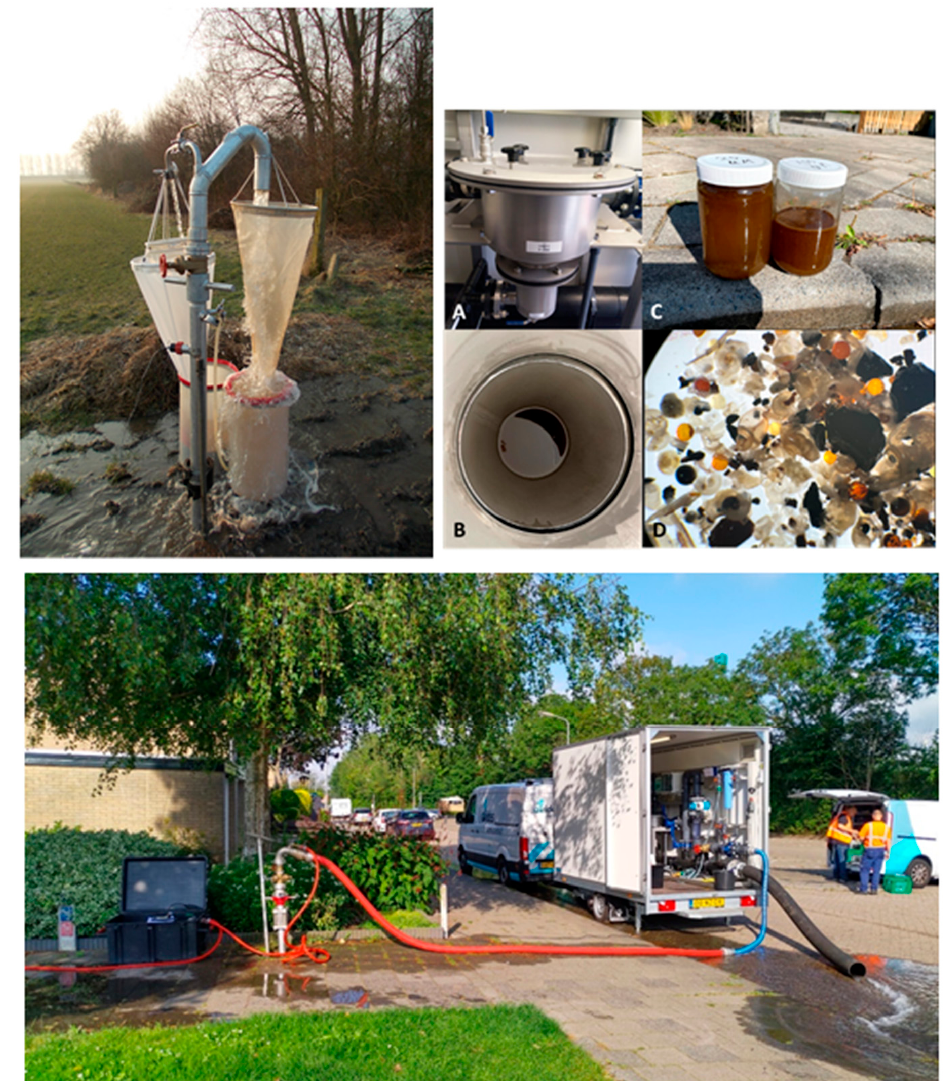
Figure 2. Sampling sediment and invertebrates during flushing. Top left: sampling with plankton nets during flushing; Below: the sampling lorry with stainless steel sieves during flushing; Top right: ( A ): stainless steel sieve inside the lorry, ( B ): sieve after sampling, ( C ): concentrated sample of loose deposits, ( D ): microscopic photo of loose deposits, sand particles, empty cochlea of gastropods and parts of isopods.